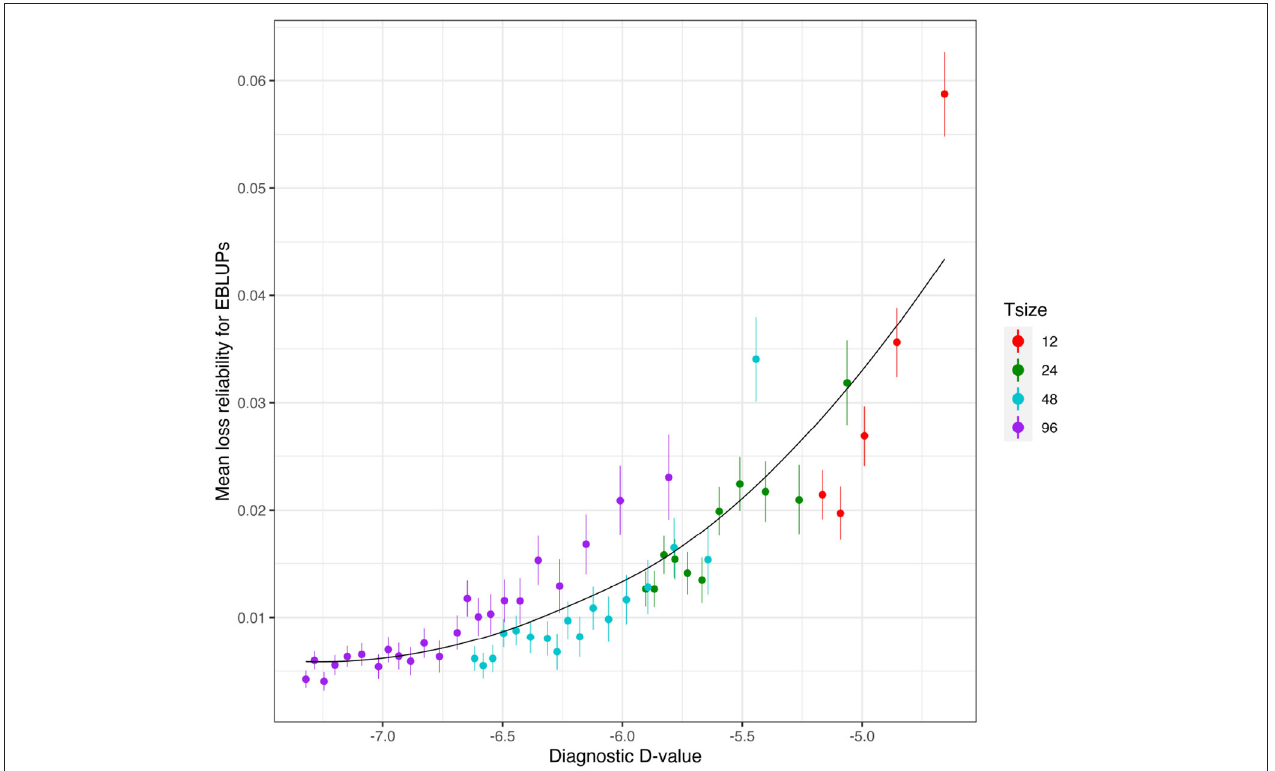
FIGURE 7 | Independent VE effects simulation study: Mean loss in reliability of the EBLUPs of VE effects for Env1 for those varieties that were present in both environments. The colours correspond to different trial sizes (trials with 12, 24, 48, and 96 varieties) and the points for each colour correspond to a sequence of connectivity levels. Also shown are standard errors for each mean (vertical lines) and a loess smoother through all the means.